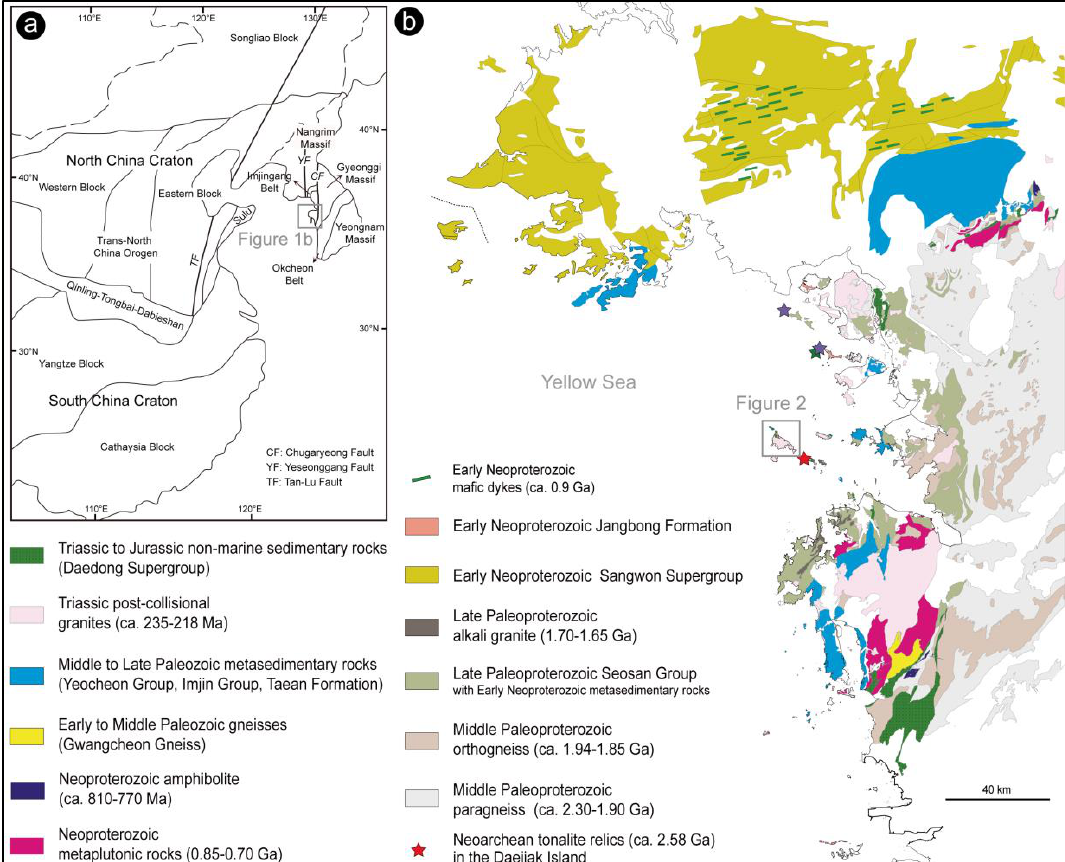
Figure 1. ( a ) Simplified tectonic map of the Korean Peninsula and adjacent areas (modified from [45,46]). ( b ) Geologic map of the western Gyeonggi Massif (modified from [47]). The gray rectangular box denotes the area of Figure 2.